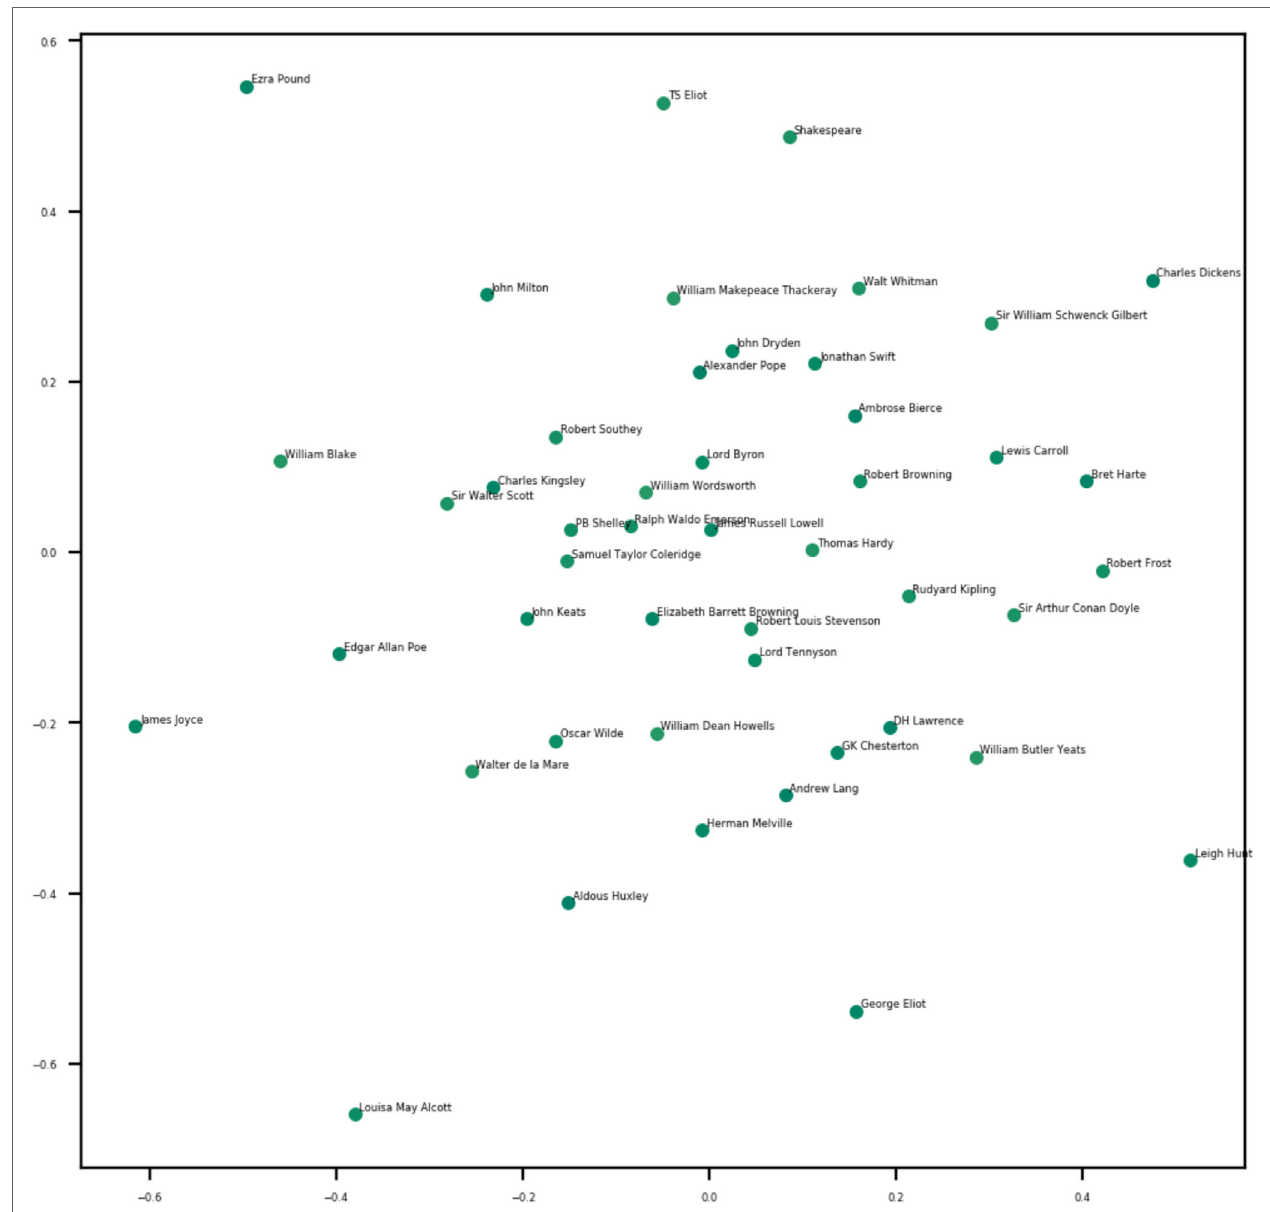
FigUre 1 | Multidimensional scaling plot of text similarity for 47 authors from the Gutenberg English Poetry Corpus based on latent semantic analysis (document-term-matrix